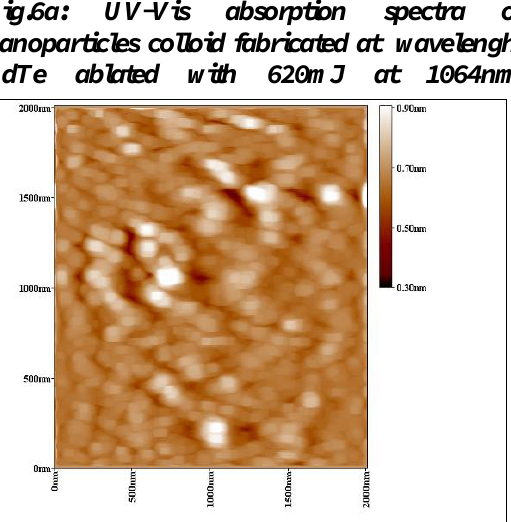
Fig.6b: (αhυ) 2 versus photon energy plot for laser of 1064nm in methanol.